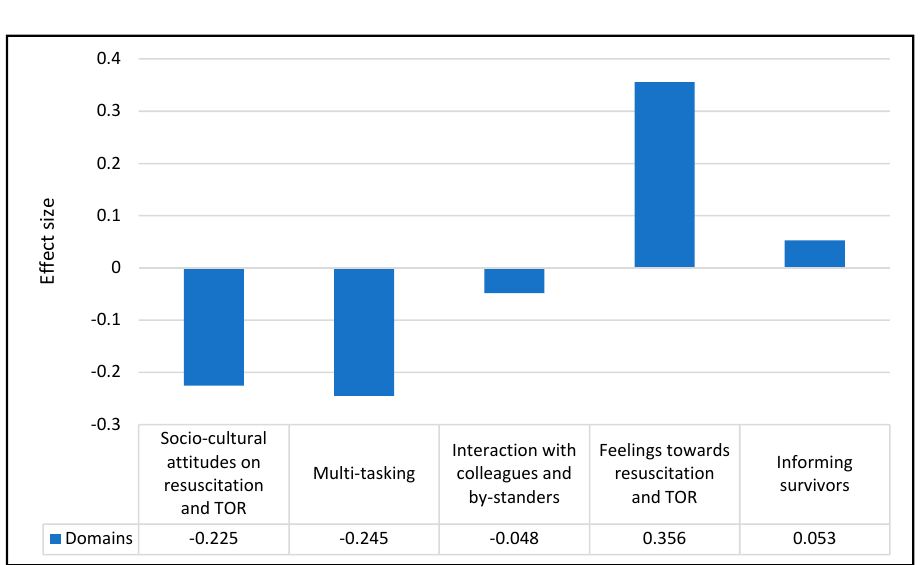
Figure 4. Effect size of the domains.